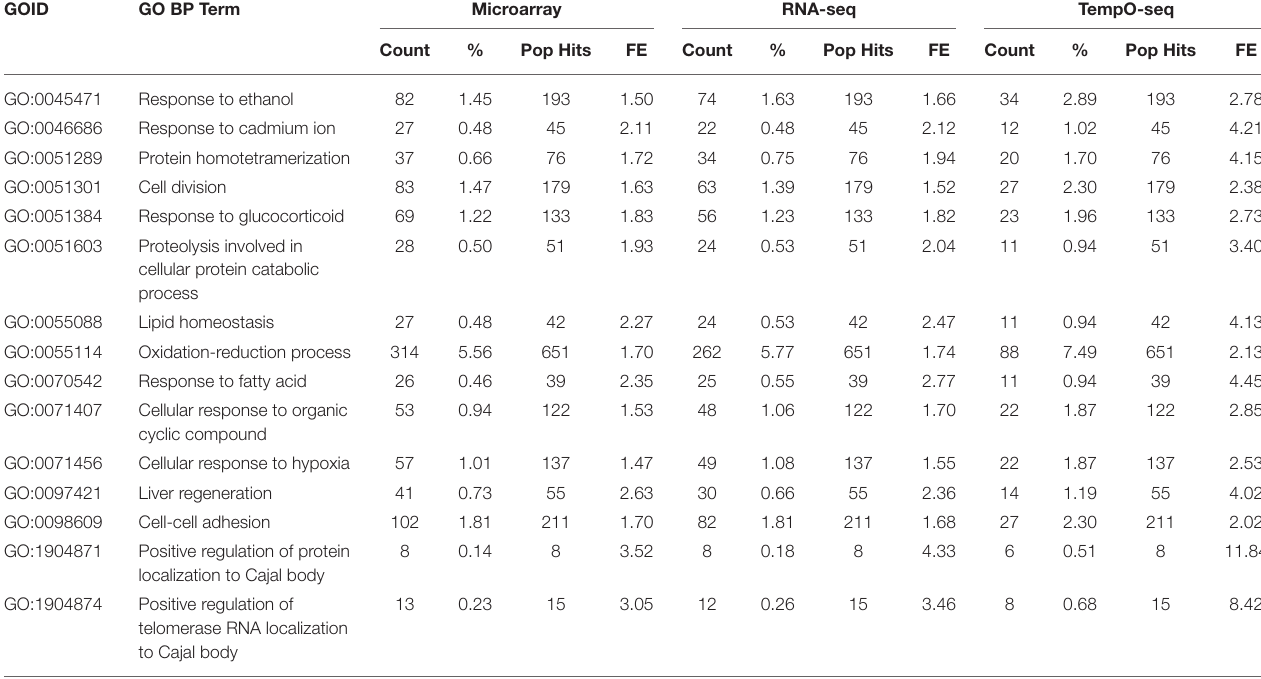
Frontiers in Genetics |